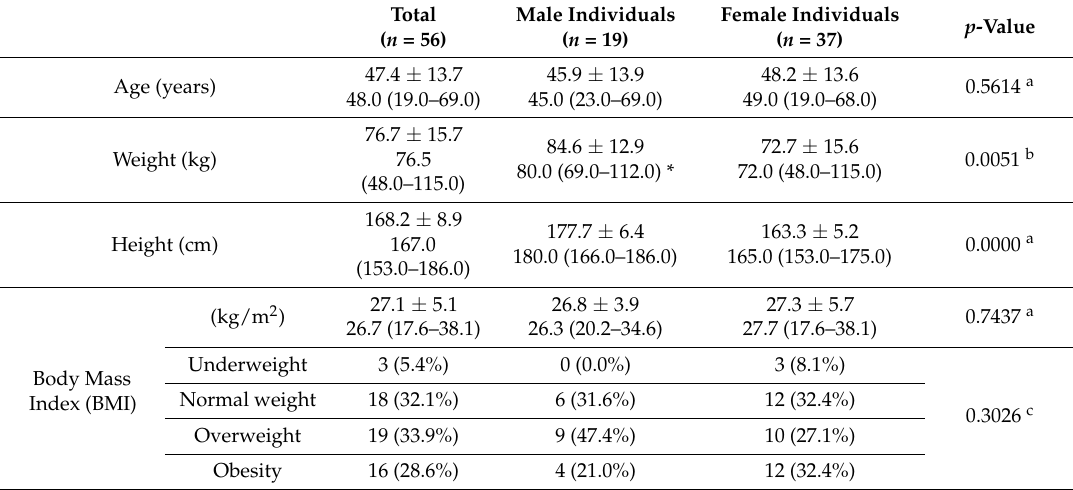
Table 1. The basic characteristics of the group of individuals with ulcerative colitis in remission phase recruited for the